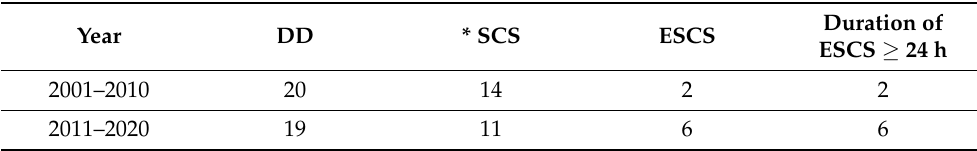
Table 6. Decadal variability in the number of tropical storms over the Bay of Bengal during the months of October–November,